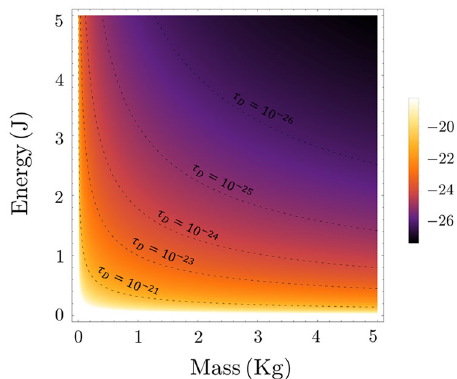
Fig. 1 Behavior of log 10 ð τ D Þ as a function of the mass m and the energy gap Δ E . As the level curves clearly show, the decoherence time τ D is signi fi cantly reduced in the regions far from the microscopic scale and nearby the mesoscopic regime. Mass and energy are expressed